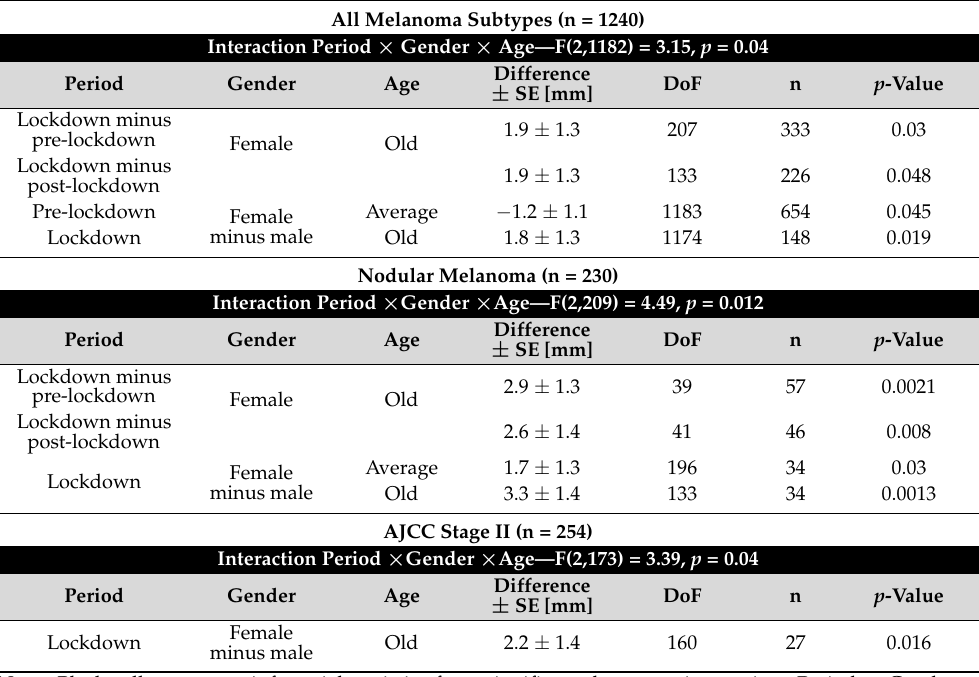
Note: Black cells represent inferential statistics from significant three-way interactions Period × Gender × Age in the Breslow thickness of diagnosed melanoma for all melanoma subtypes (top), as well as only for nodular melanomas (middle) and for melanomas classified as stage II (bottom), according to the AJCC. The white cells represent significant pairwise differences for Breslow thickness in post-hoc analyses following the significant interactions reported in the black cells. SE = standard error of the model; DoF = degrees of freedom; n = sample